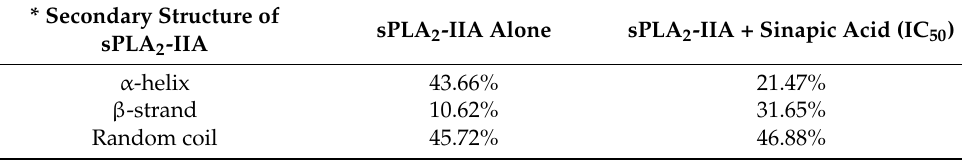
Table 4. Secondary structure of sPLA 2 -IIA enzyme upon addition of sinapic